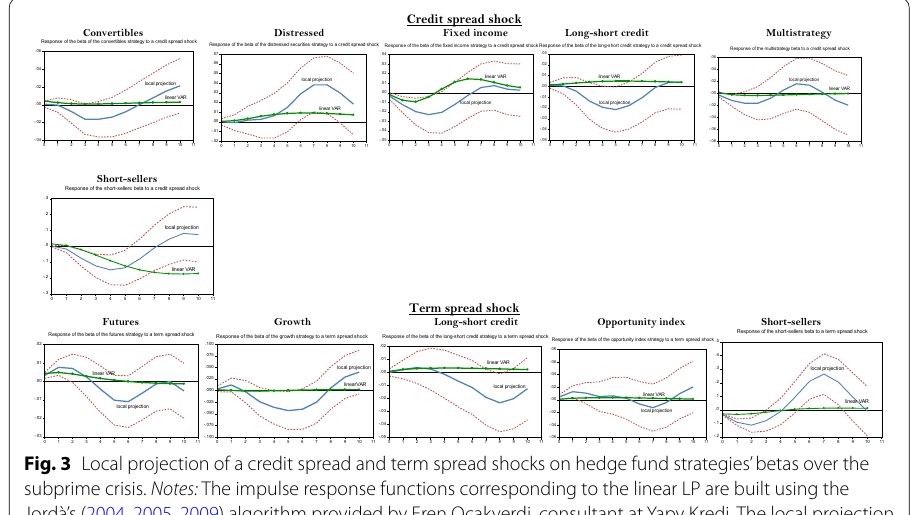
Fig. 3 Local projection of a credit spread and term spread shocks on hedge fund strategies’ betas over the subprime crisis. Notes: The impulse response functions corresponding to the linear LP are built using the Jordà’s (2004, 2005, 2009) algorithm provided by Eren Ocakverdi, consultant at Yapy Kredi. The local projection of a beta strategy is performed over the subprime crisis (2007Q3–2009Q4). We also provide the linear VAR estimated over the whole sample period selected as benchmark. The confidence interval of the LP impulses, computed at the threshold of 95%, is in dotted lines. As explained in the paper, our model comprises five endogenous shocks, placed in the following order to perform the Cholesky factorization (Sims 1980) required to build structural shocks: GDP growth, term spread, credit spread, beta (own shock) and VIX. As usual, these variables are ordered by increasing level of endogeneity. This order relies on the conventional information criteria: Akaike and Schwartz criteria. Only strategies whose impulses response functions are significant at a level of 10% or less are reported in this